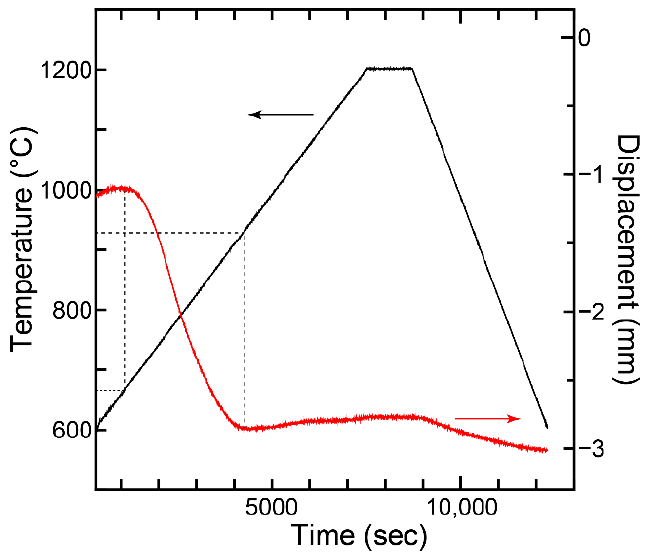
Figure 3. SPS temperature and displacement versus time for FAP ceramics during sintering at 1200 °C.